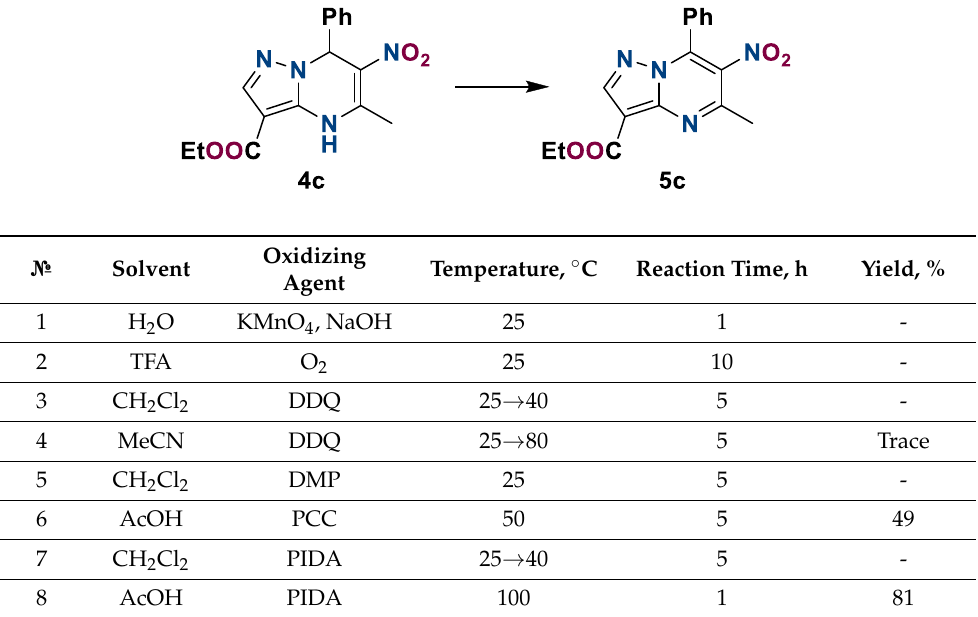
Table 1. Oxidation of 4c and reaction parameters.